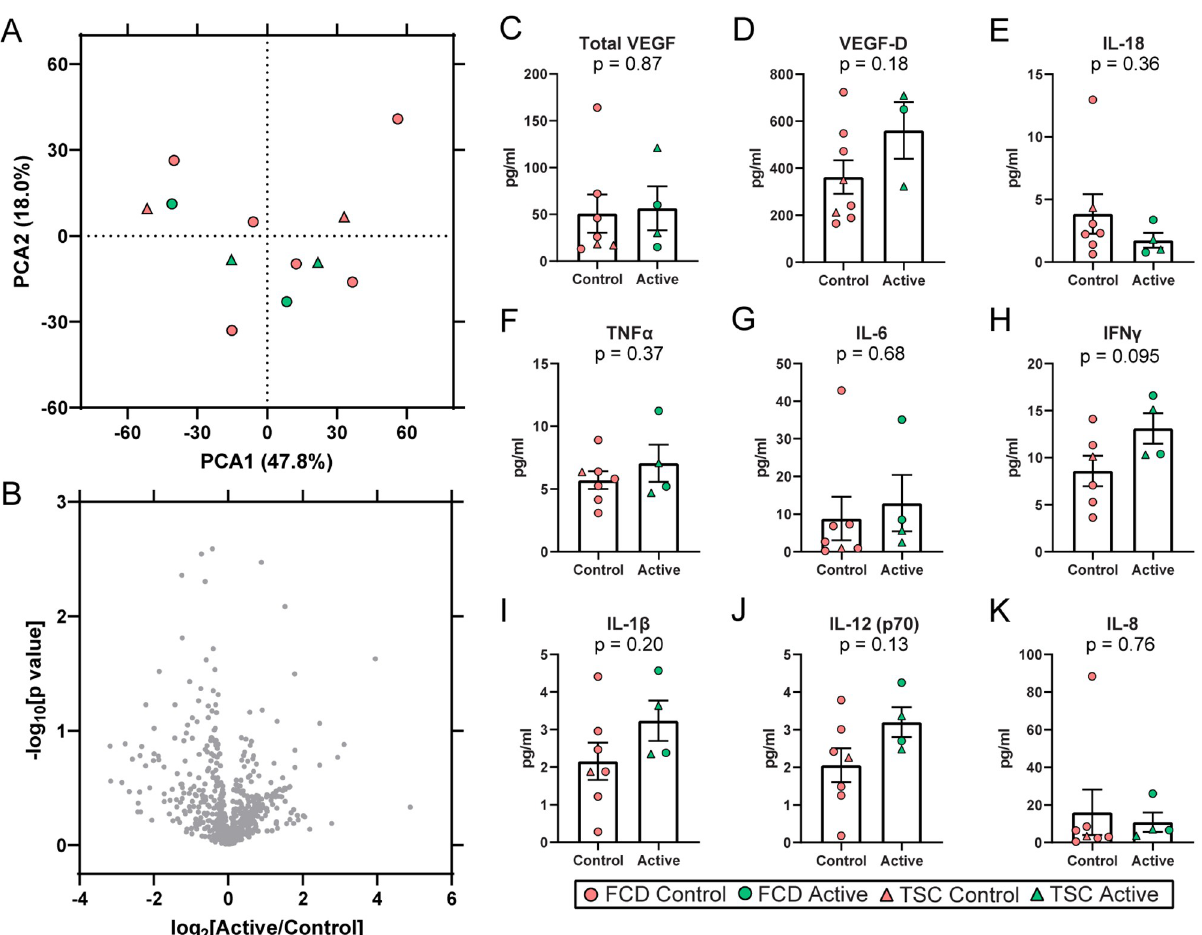
Fig 5. Plasma proteomics and cytokine levels. A) Proteomics was performed on plasma obtained at time of surgical resection after 7 days everolimus. PCA indicates no segregation of Active from Control participants, nor by clinical diagnoses (FCD, TSC). B) Differential expression analysis of plasma proteins indicated no altered proteins in Active versus Control participants at FDR < 5%, nor at FDR < 15%. C-K) Plasma cytokine levels were evaluated at time of surgical resection. There were no significant differences in the cytokines evaluated.